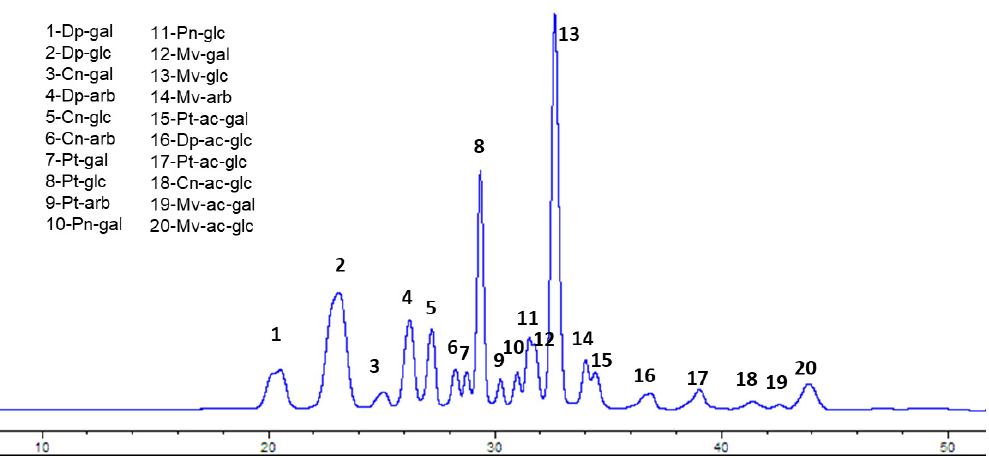
Figure 1. HPLC profile of Alaskan bog blueberry with identification of individual peaks. Dp= delphinidin, Cn = cyanidin, Pt = petunidin, Pn = peonidin, Mv = malvidin, ac = acetoyl, gal = galactose, glc = glucose, arb = arabinose.